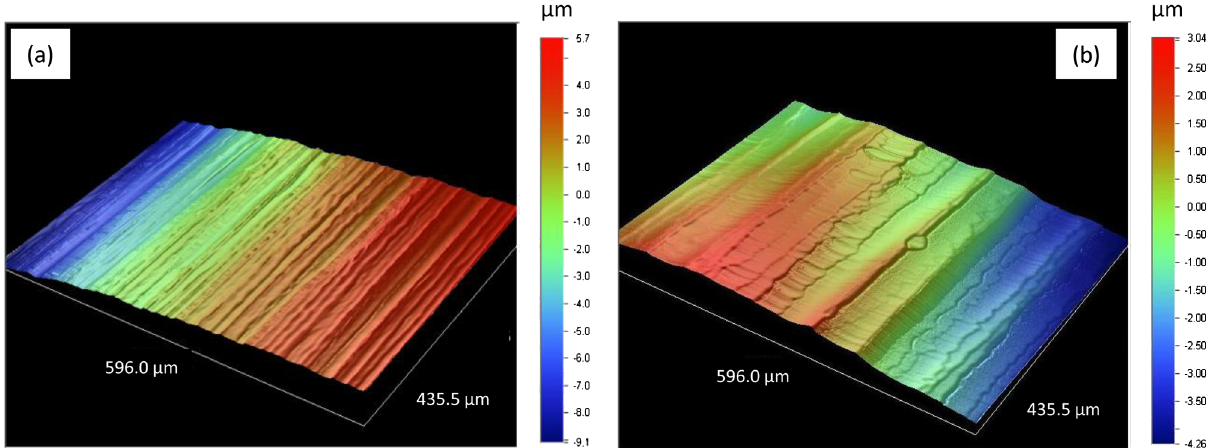
EVALUATION OF NIOBIUM AS CANDIDATE ELECTRODE . .